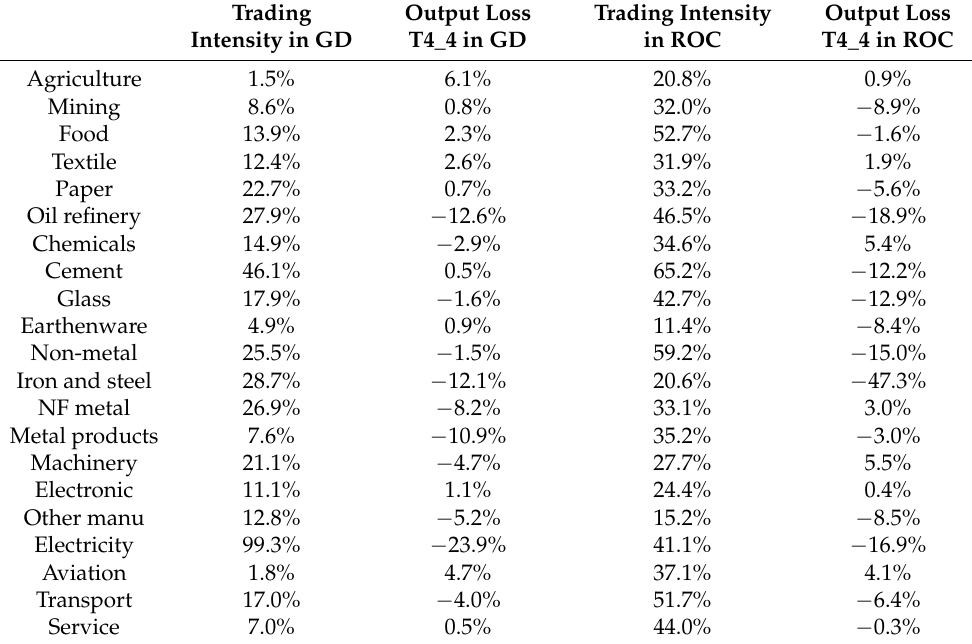
Table 4. GD and ROC trading intensity with output loss in